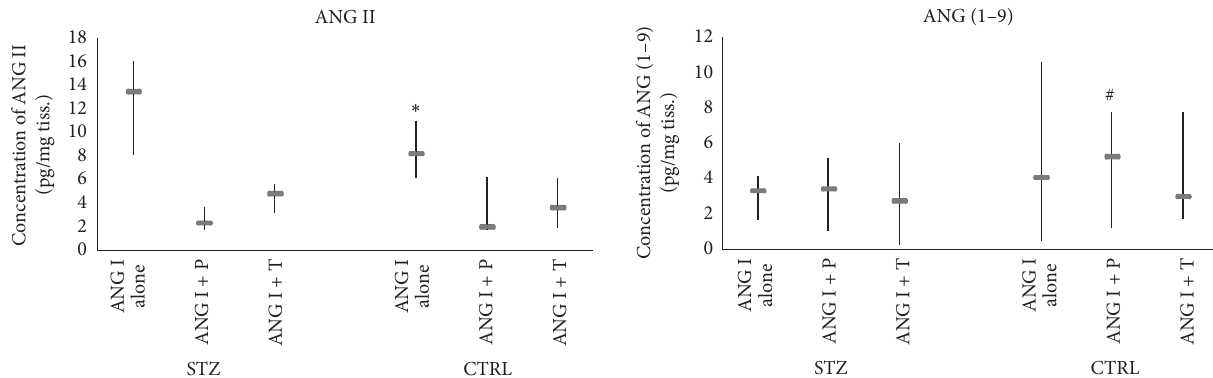
Figure 4: Concentrations (median, minimum, and maximum) of ANG II and ANG (1–9), produced from exogenously added ANG I, by the aortic rings of STZ and CTRL rats, pretreated with perindoprilat (ANG I + P) or thiorphan (ANG I + T). ∗ 𝑃 < 0.05 , ANG II concentration was higher in (ANG I only) group of STZ aorta. # 𝑃 < 0.05 , ANG (1–9) concentration was higher in (ANG I + P) group of CTRL aorta.